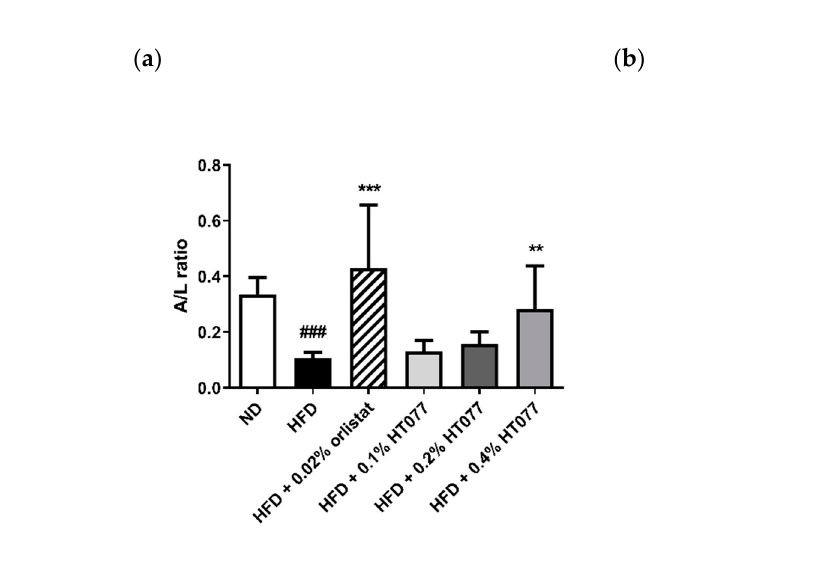
Figure 4. Effects of an extract mixture of Prunus persica and Nelumbo nucifera (HT077) on serum adiponectin ( a ) and leptin ( b ) levels and the adiponectin / leptin (A / L) ratio ( c ) in C57BL / 6 mice fed a high-fat diet (HFD). Mice received either a normal diet (ND), HFD, HFD containing 0.02% orlistat, or HFD containing 0.1, 0.2, or 0.4% HT077 for 12 weeks. All values are presented as the mean ± SD ( n = 8 for ND, 16 for HFD, and 12 for the other groups). ### p < 0.001 vs. ND group; * p < 0.05, ** p < 0.01, and *** p < 0.001 vs. HFD control group.